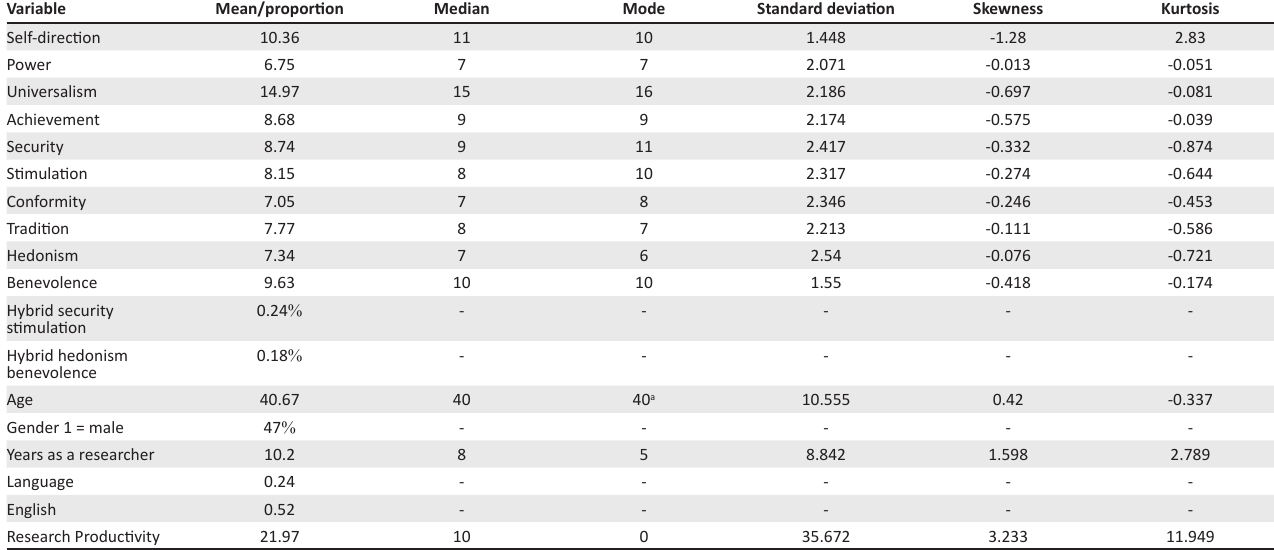
TABLE 2. Measures of location, central tendency and statistical